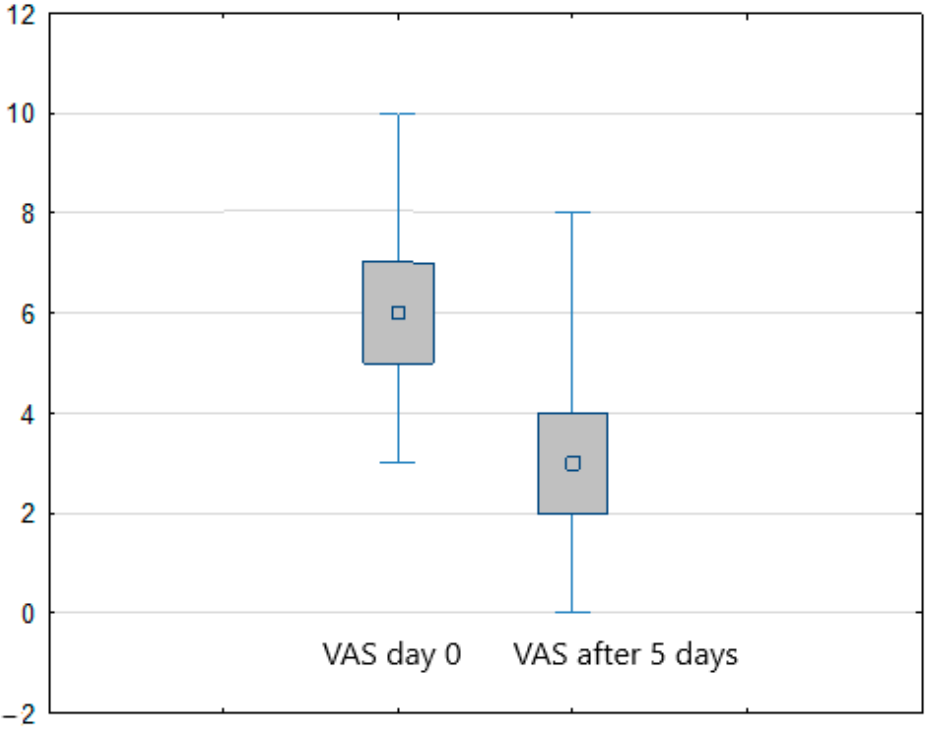
Figure 1. Reduction of pain (VAS score) in the FREMS (+ SOC) group after 5 days of treatment.